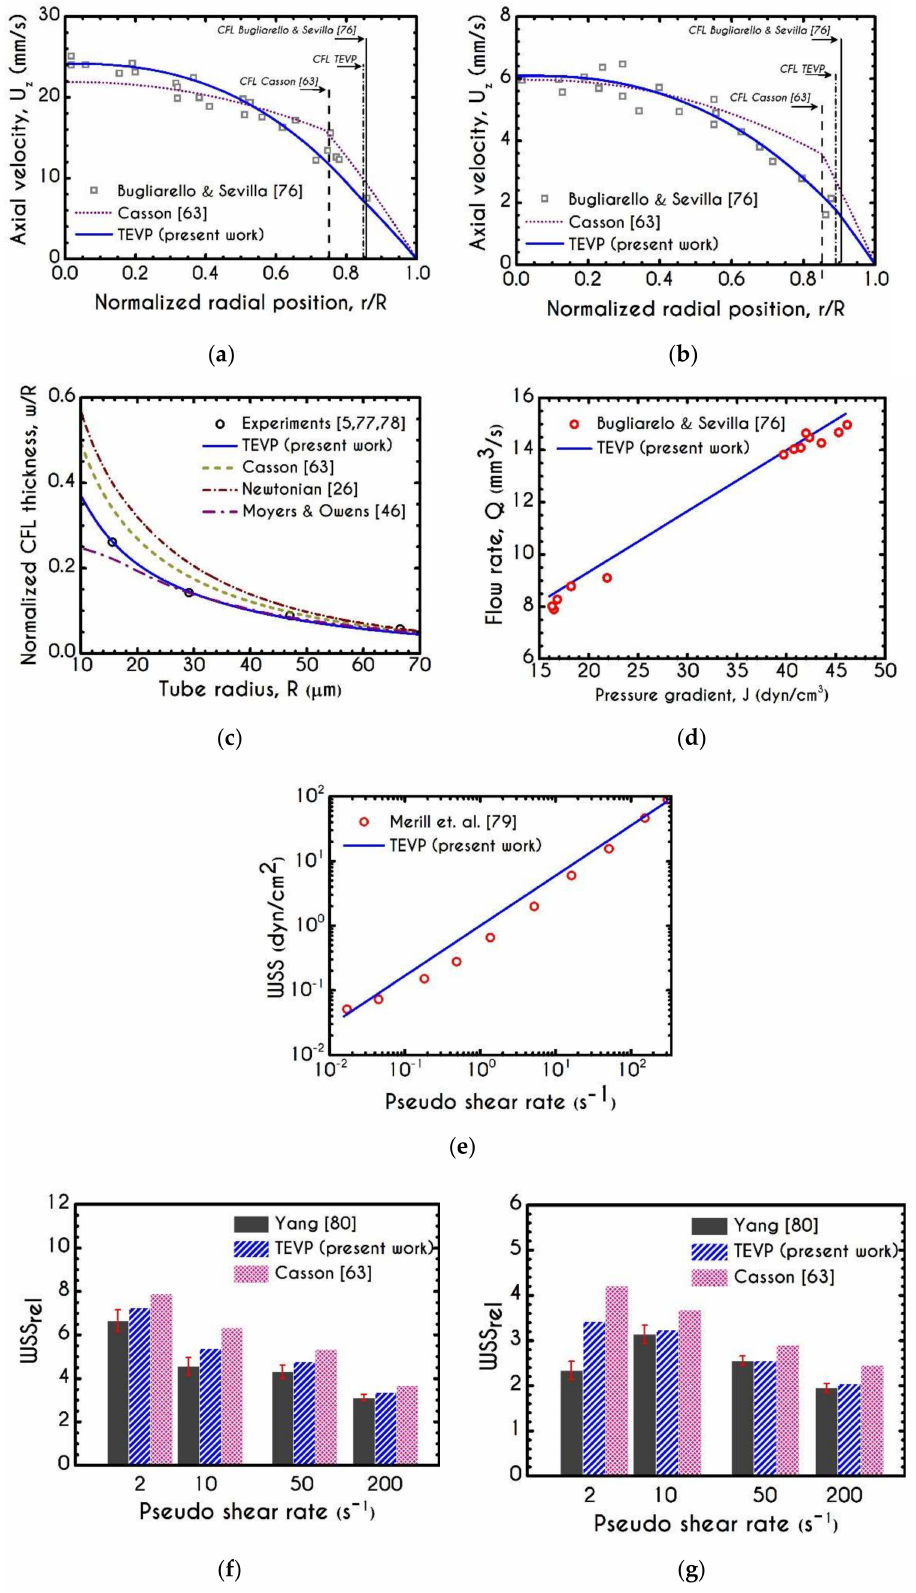
Figure 2. Validation of our model predictions with experimental data. Blue solid lines are steady-state simulation results of our model while open circles and cubes are experimental measurements for ( a ) velocity profile for R = 20 µ m under the hemorheological conditions reported in Bugliarello